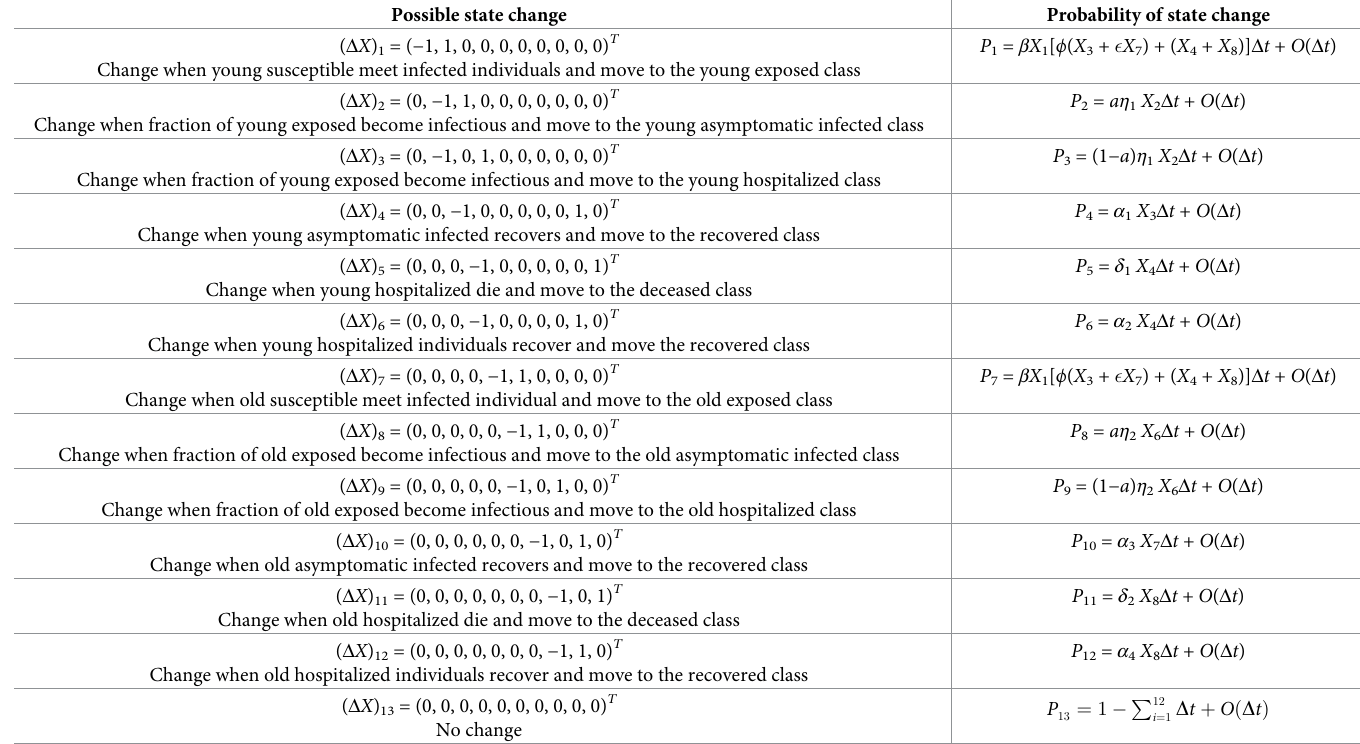
Table 2. Possible changes of states and their probabilities. Possible state change Probability of state